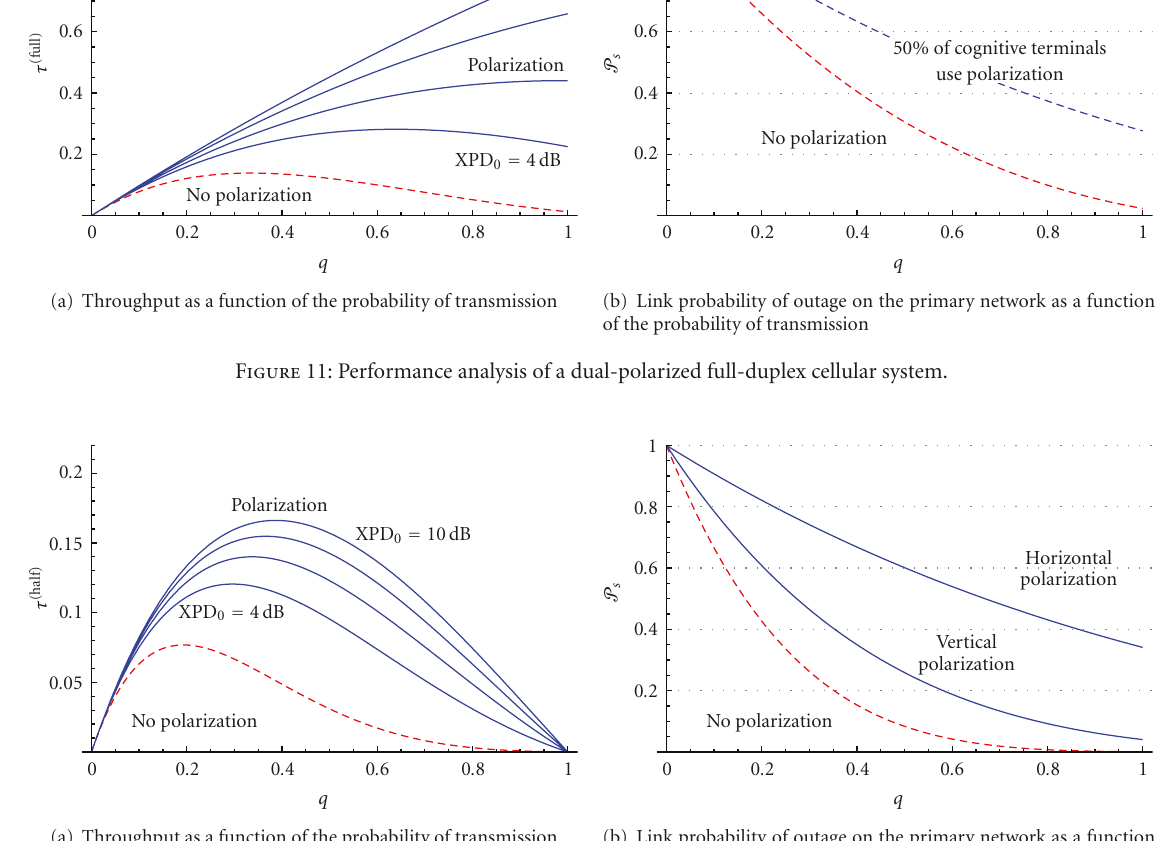
(b) Link probability of outage on the primary network as a function of the probability of transmission